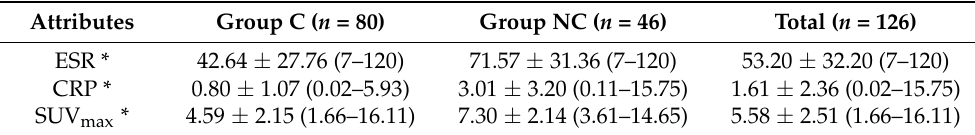
Figure 2. Flowchart of the decision classification in the clinical assessment. Among the decisions with residual PVO (no remission), the decisions showing the presence of causative bacteria and/or an aggravated PVO lesion on MRI were only classified into group NC ( n = 41), and the others ( n = 25) were excluded from the study. The 85 decisions with remission were followed-up with a minimum of six months after discontinuing antibiotic therapy, and the 80 decisions with no recurrence were finally classified into group C. The five recurrences were classified into group NC. Therefore, the final analysis was performed with 80 patients in group C and 46 in group NC. PVO, pyogenic vertebral osteomyelitis; MRI, magnetic resonance imaging; Group C, cured; Group NC, non-cured. Table 3. Clinical features between groups C and NC.